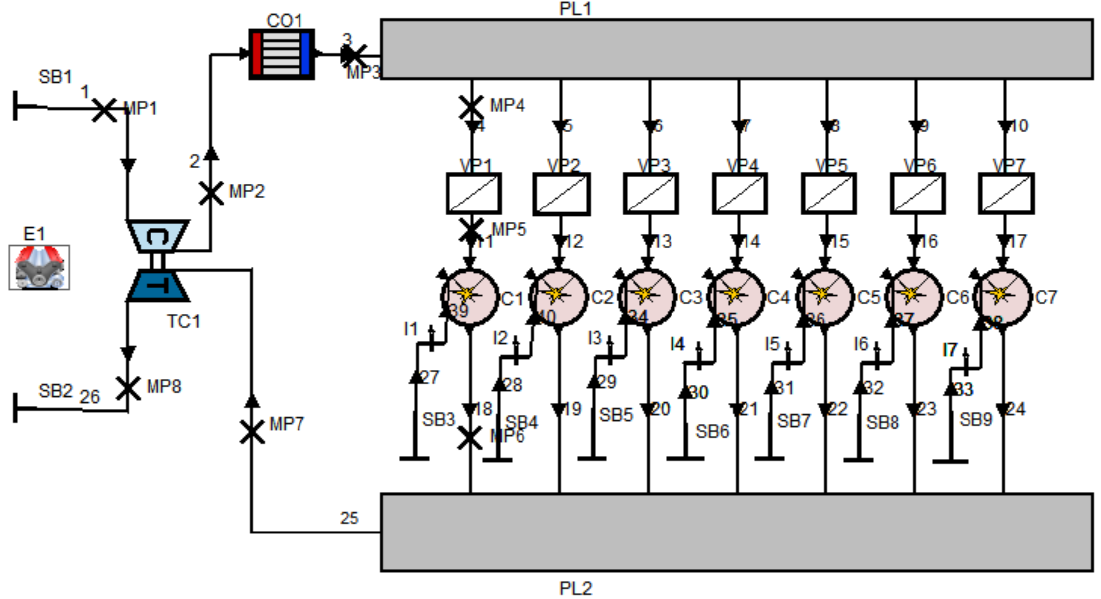
Figure 2. 7X82DF simulation model in AVL-BOOST. Table 2. The main definitions of the